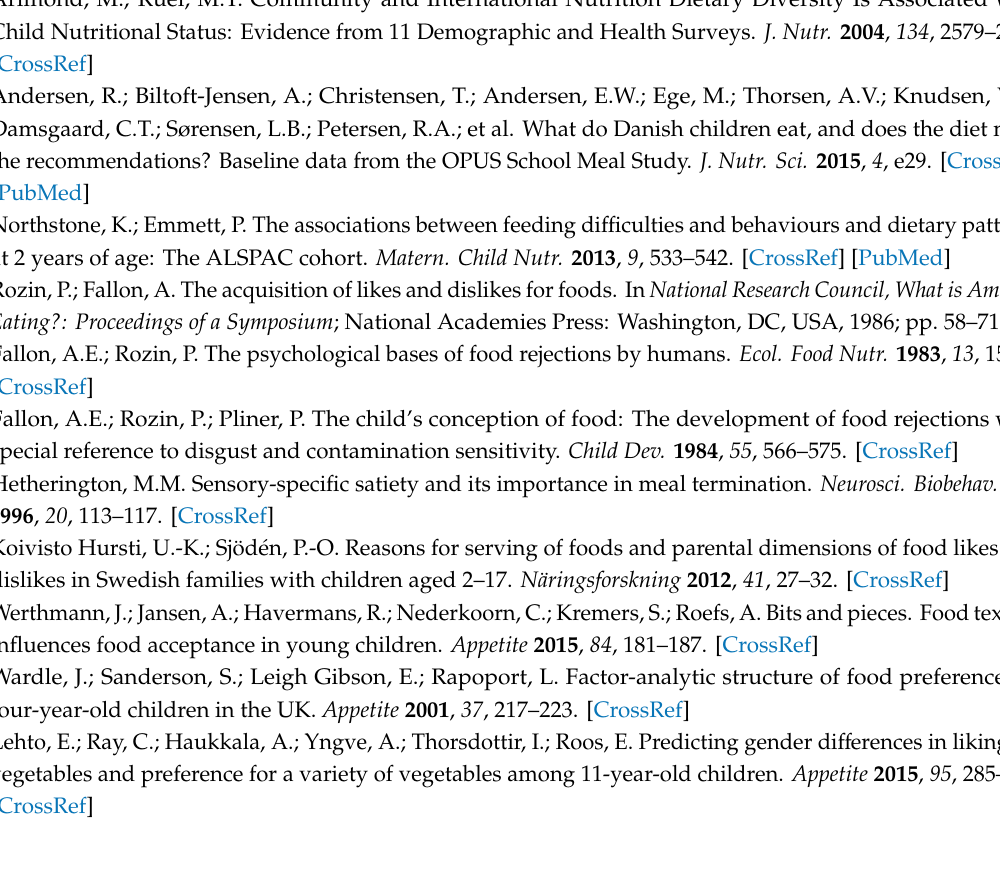
Table S1: List of references and reasons in food choice and food preferences in children and